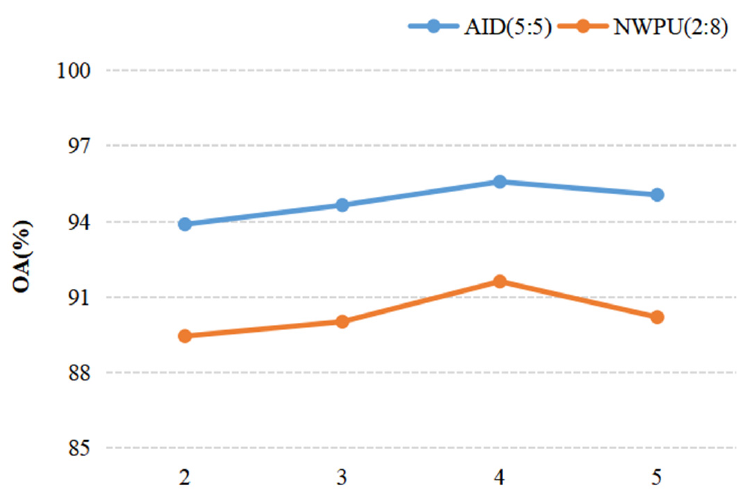
Figure 10. The influence of the ConvLs number.